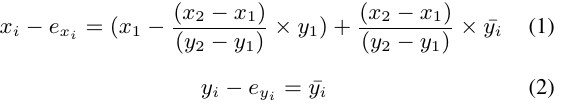
(b) The points in the buffering area are collected as the measurements for LS adjustment.